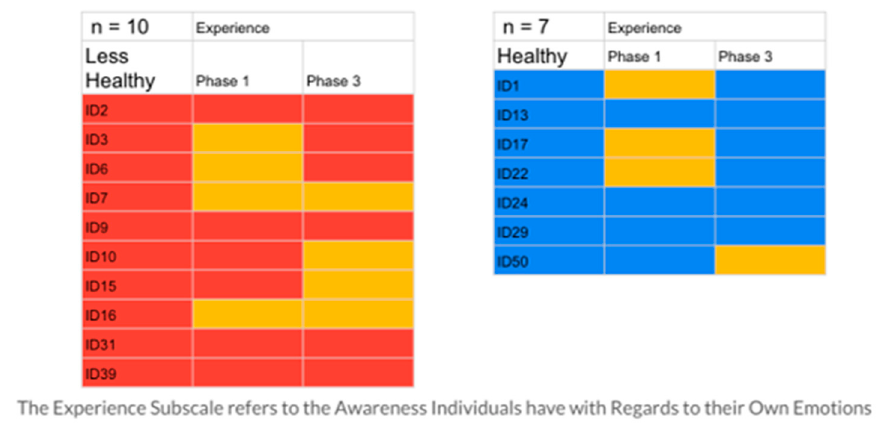
Figure 4. The Avoidance Scale EPS: Less Healthy vs. Healthy Coping Groups.